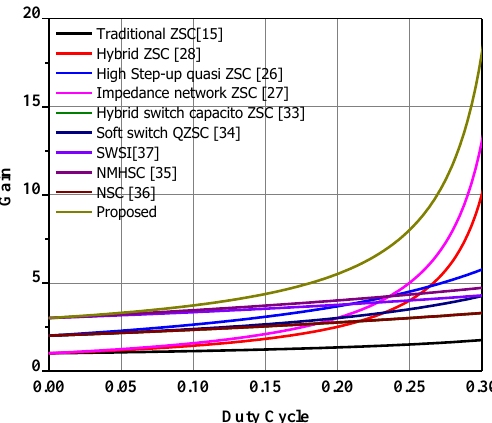
Figure 13. Comparison of the boost ability for the proposed and conventional converters.